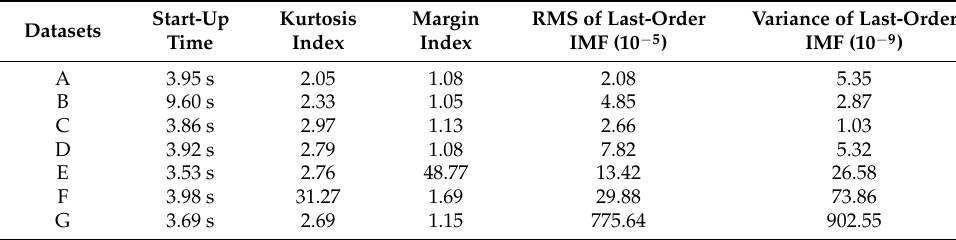
Table 6. The average value of the indicators.